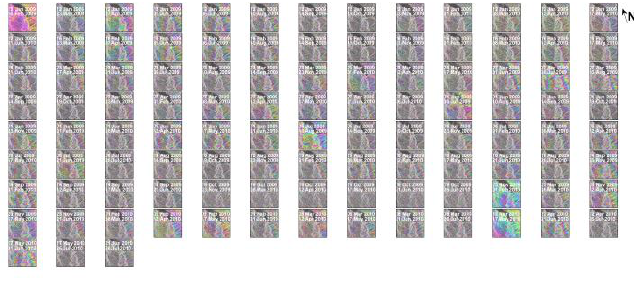
Fig. 2 Interferograms for the Tehri region. The image acquired on 19th October 2009 is chosen as the master image.